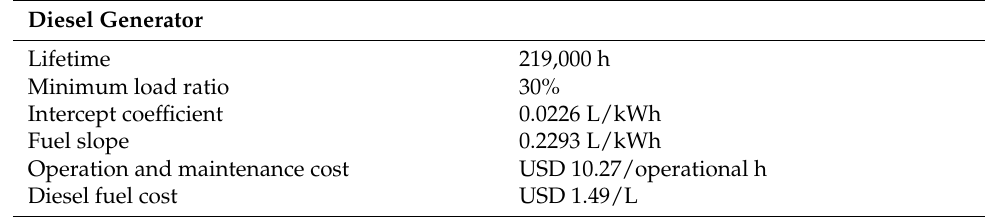
Table 1. Diesel generator data.